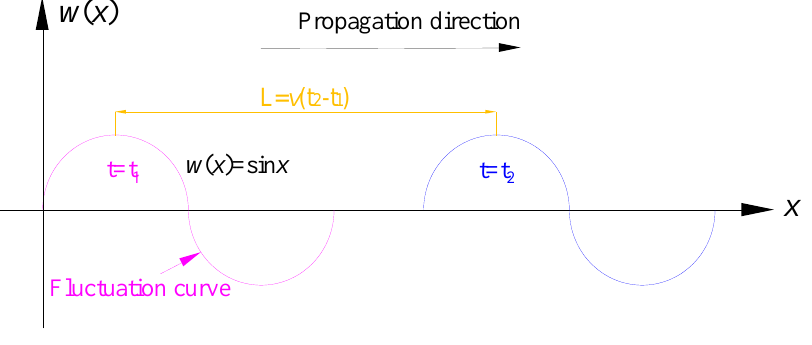
Figure 4. Propagation diagram of wave curve. destructive propagation, that is, in the full mining stage, the waveform of the subsidence velocity curve remains unchanged in the propagation process and propagates forward along the advancing direction of the working face at the mining speed. With the advance of the working face, the surface subsidence velocity curve at t 2 can be considered obtained after the subsidence velocity curve at t 1 translates the distance L along the propagation direction. Based on the above idea, after the prediction function model of surface subsidence velocity at a certain time is obtained, the rest time can be obtained by translating the prediction model for a certain distance along the advancing direction of the working